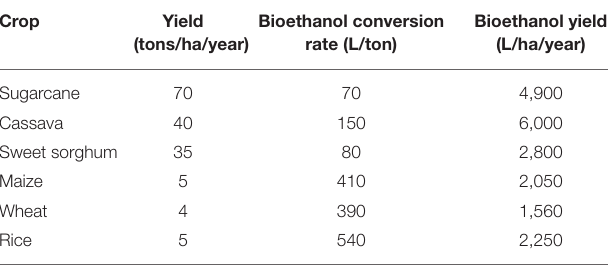
TABLE 1 | Comparison of bioethanol production from different energy crops. Crop Yield Bioethanol conversion Bioethanol yield (tons/ha/year) rate (L/ton)